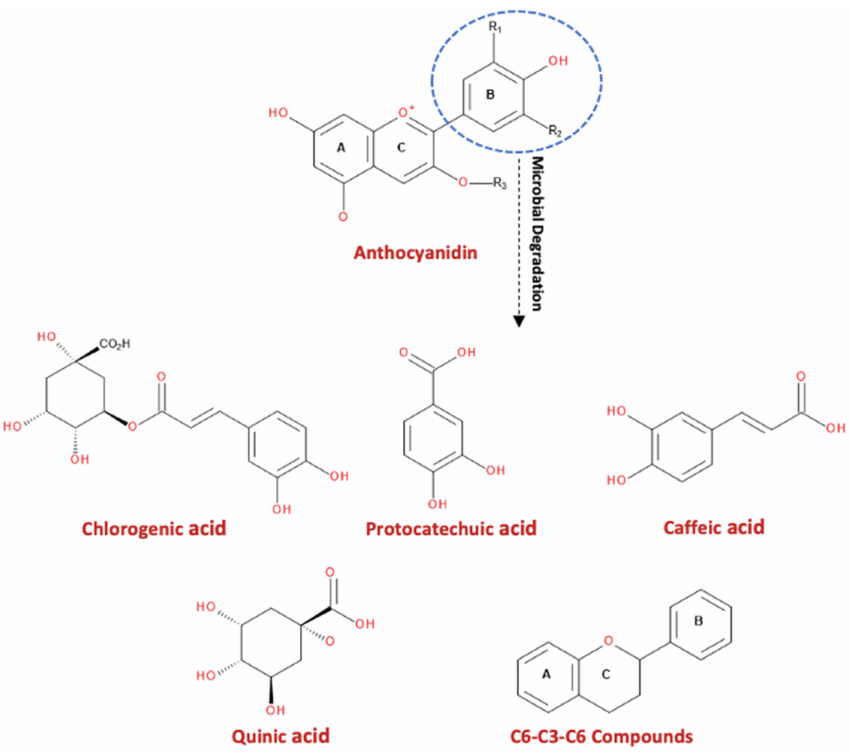
Figure 3. Microbial degraded metabolites of anthocyanidins according to the study of Olivas- Aguirre et al.